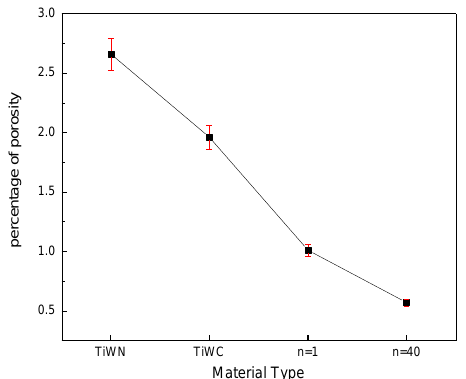
Figure 8. Percentage of porosity as a function of the